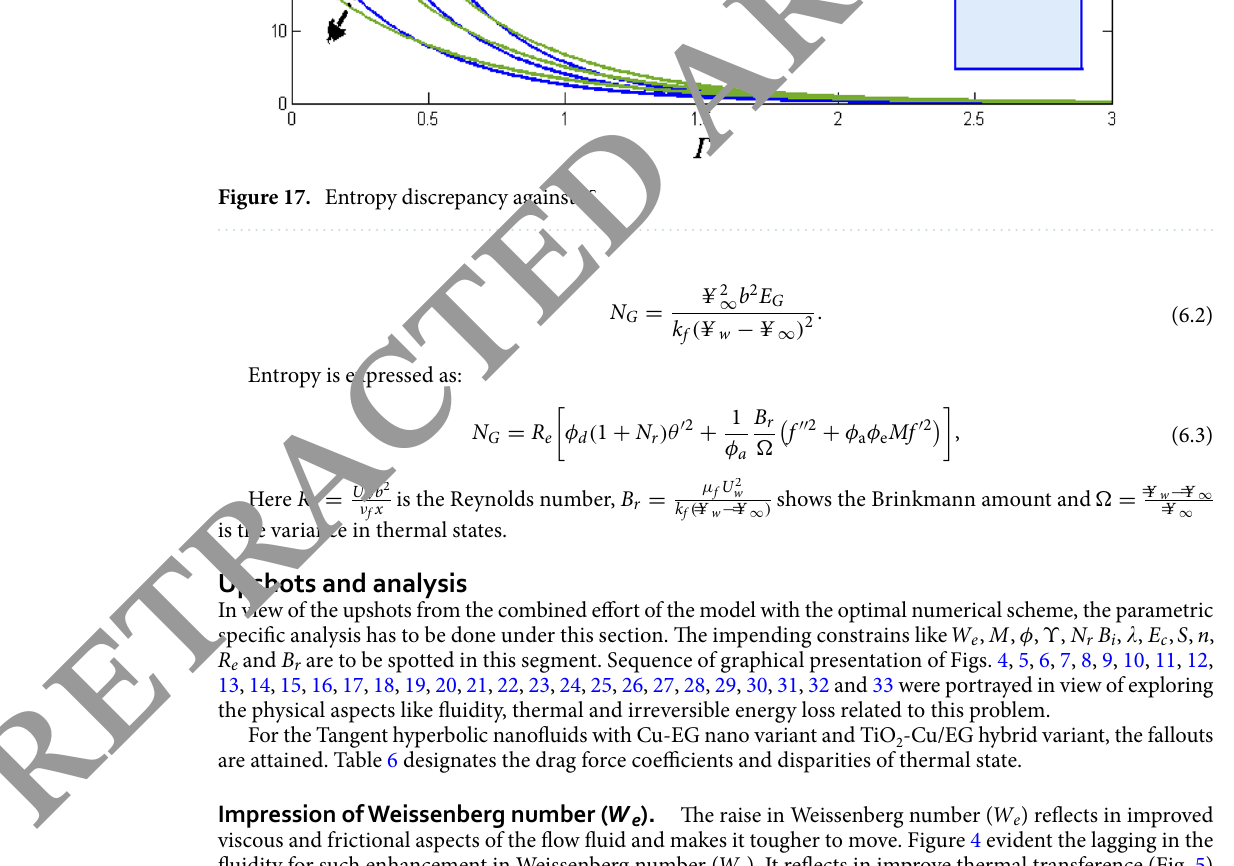
Figure 17. Entropy discrepancy against ϒ